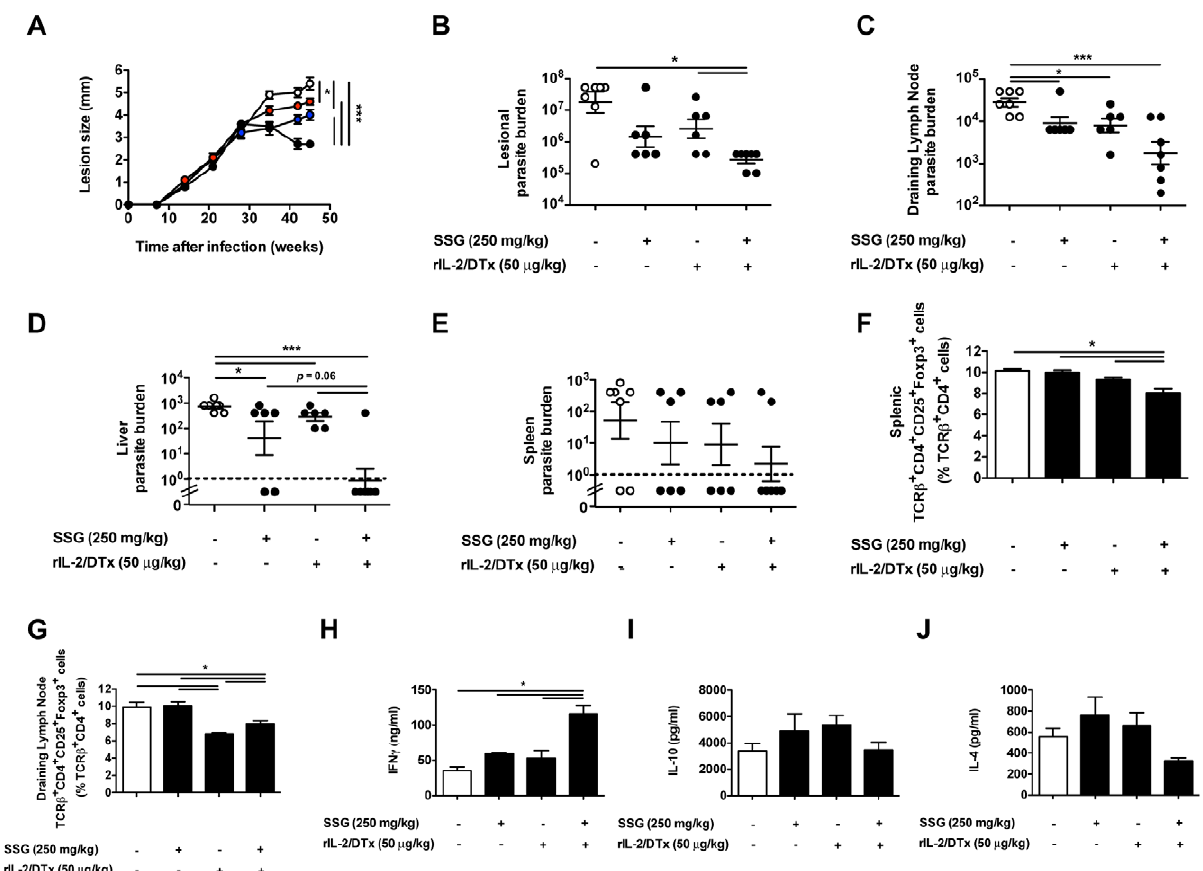
Figure 6. Combined therapy enhances resolution of experimental L.major infection in BALB/c mice. BALB/c mice were infected as in Figure 2. ( A ) Lesion size. Beginning 30 d after infection, mice were treated: daily for 10 d with SSG (250 mg/kg; blue circles); 3 times at 5 d intervals with rIL-2/DTx (50 m g/kg; red circles); daily for 10 d with SSG (250 mg/kg) plus three times at 5 d intervals with rIL-2/DTx (50 m g/kg; black circles); or with normal saline (per route and schedule for 10 d SSG plus 3 doses of rIL-2/DTx; open circles). ( B ) Lesional parasite burden; ( C ) Parasite burden in draining lymph nodes; ( D ) Parasite burden in liver (dotted line represents the limit of detection in the assay); ( E ) Parasite burden in spleen; ( F ) Splenic T reg (TCR b + CD4 + CD25 + Foxp3 + ) percentage; ( G ) Draining lymph node T reg percentage; and antigen-specific ( H ) IFN- c , ( I ) IL-10 and ( J ) IL-4 secretion (by leukocytes isolated from lesional lymph nodes and cultured in presence of soluble Leishmania antigen) were quantified 45 d after infection. Data represent means + / 2 SE of 6–7 mice/group in a single experiment (with individual data points shown for parasite burden); ( A ) MANOVA P , 0.0003; ANOVA P , 0.0001; Tukey’s correction; * P , 0.05, ** P , 0.01, *** P , 0.001. ( B–E ) Non-parametric ANOVA (Kruskal-Wallis test for over-all comparison of treatment to no treatment); ( B ) P , 0.02; ( C ) P , 0.006; ( D ) not statistically significant; ( E ) P , 0.005. Wilcoxon test (for pairwise comparisons), ( B–E ) * P , 0.05, ** P , 0.01. ( F–H ) ANOVA P , 0.0001; Tukey’s correction; * P , 0.05, ** P , 0.01, *** P ,